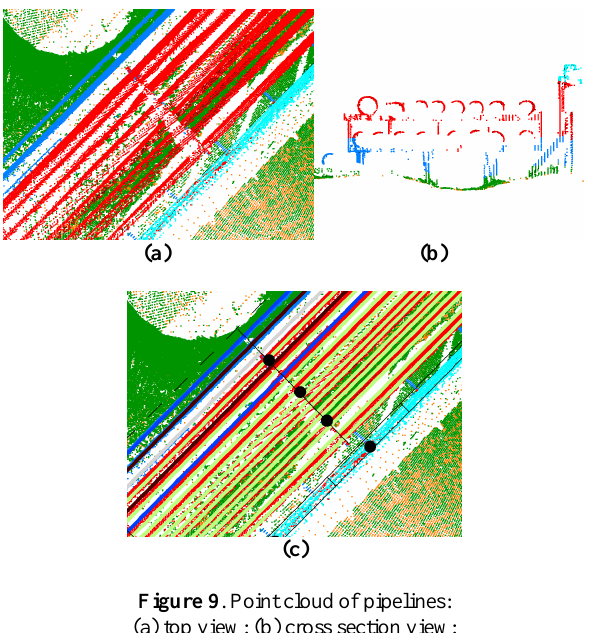
Figure 9 . Point cloud of pipelines: (a) top view; (b) cross section view; (c) top view with vectorized pipelines and supporting structures.